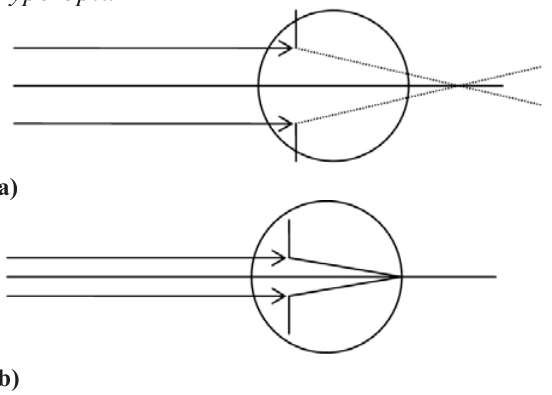
Figure 5. The hyperopic eye: ( a ) Viewing an object at a dis- tance, with accommodation relaxed. ( b ) Viewing an object at a distance, with accommodation in